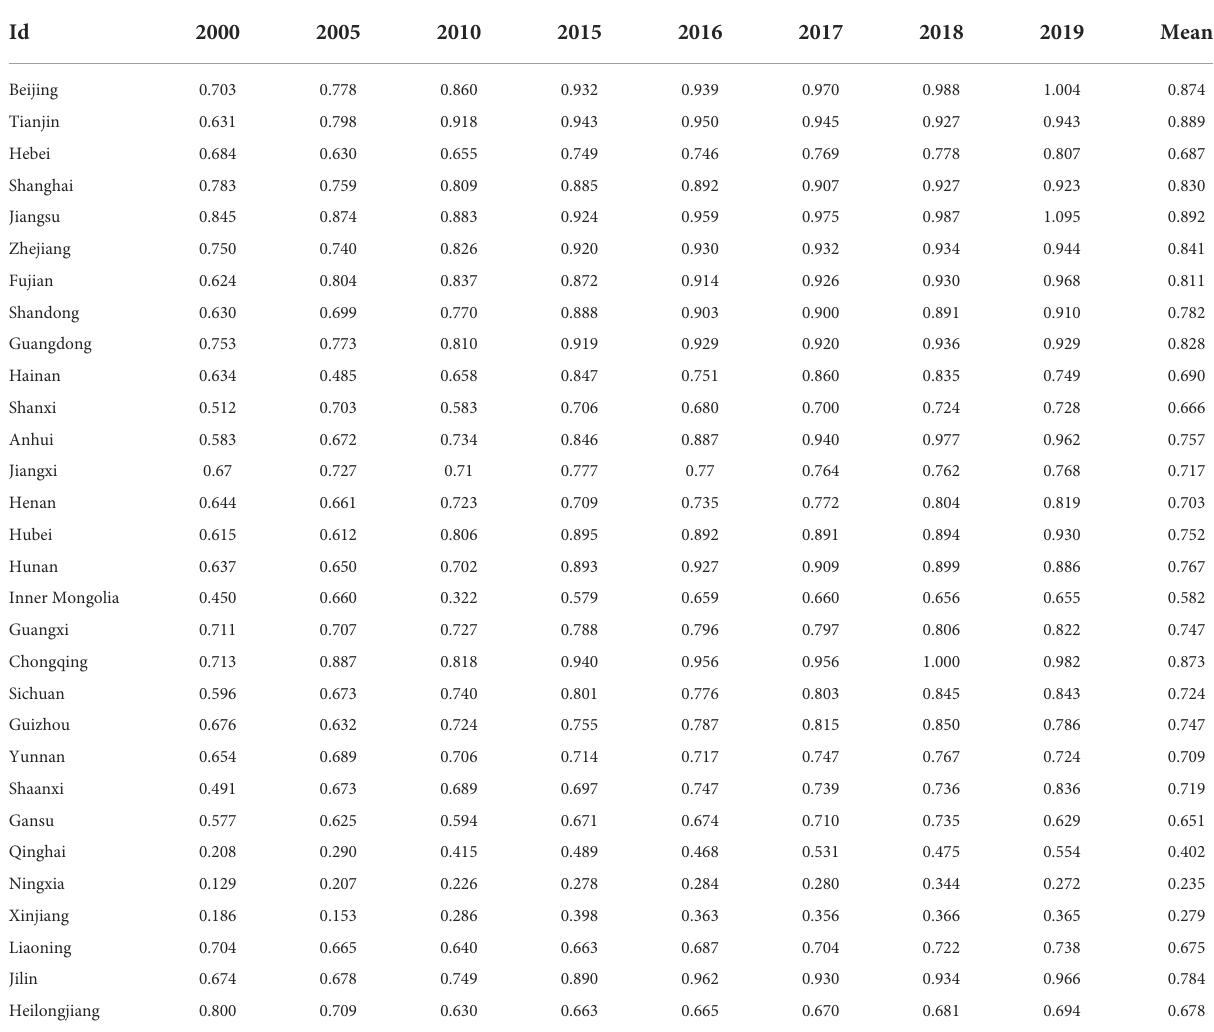
TABLE 2 GTFP of China’s provincial pharmaceutical industry from 2000 to